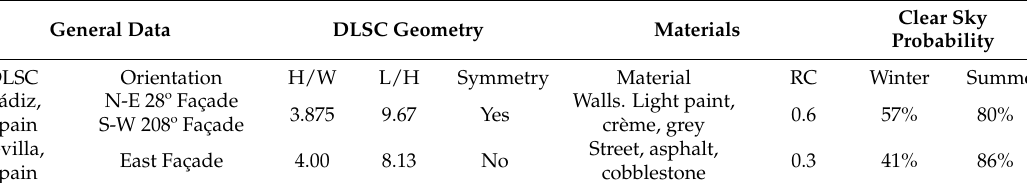
Table 1. Data assumptions for validation